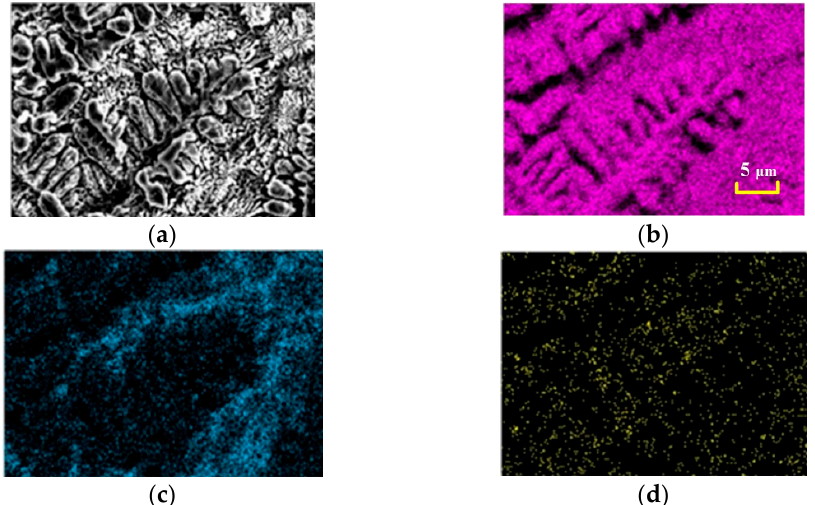
Figure 9. Element distribution map of melted area with electron beam remelting. ( a ) SEM micrograph; ( b ) Mo; ( c ) Si; ( d ) B.